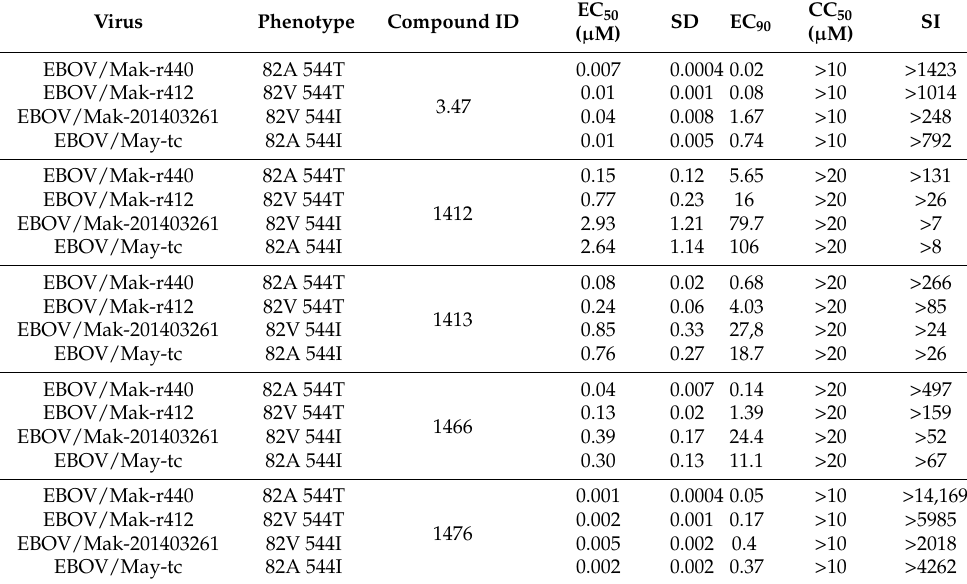
Table 3. Antiviral activity of EBOV entry inhibitor 3.47 and its